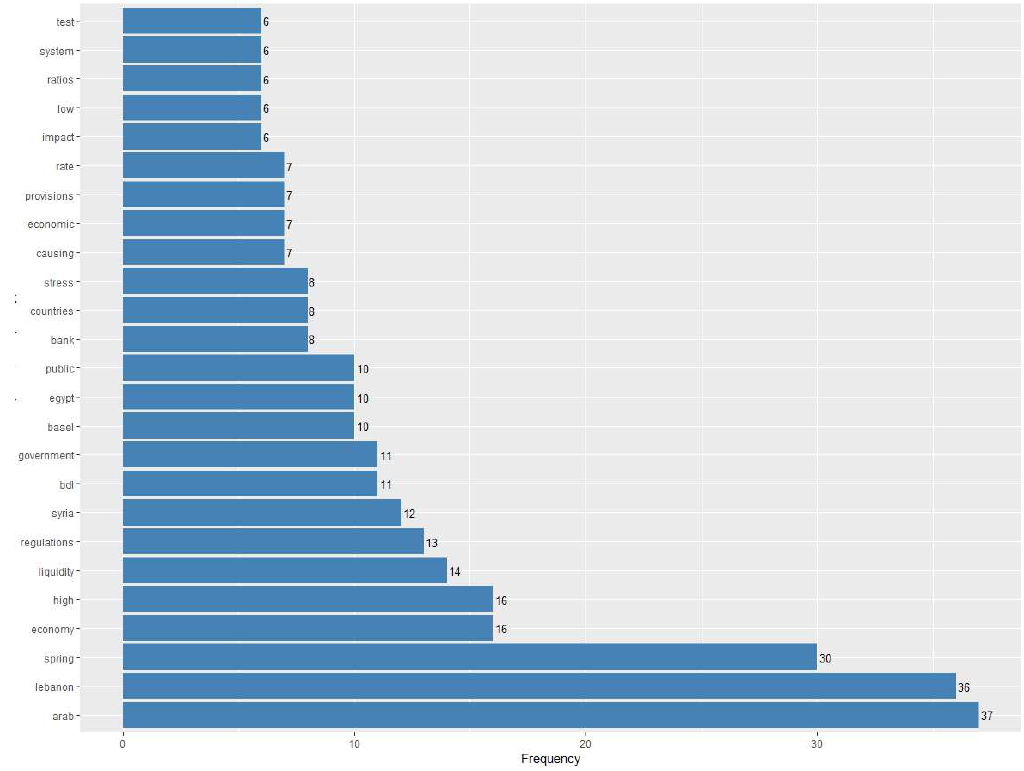
Figure 8. Histogram of terms used in the interview